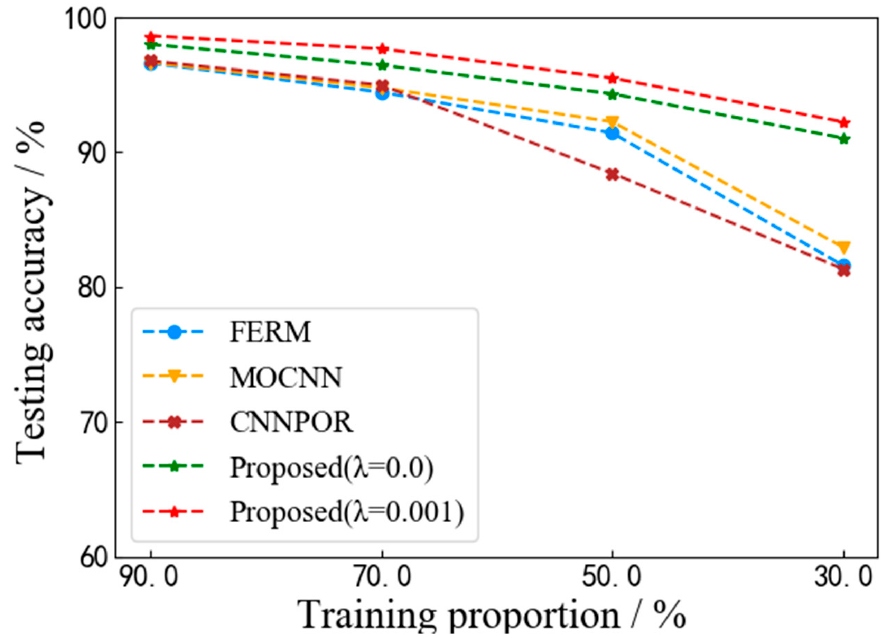
Figure 8. Acc curves with different proportions of training sets from the ExFRIDA dataset.